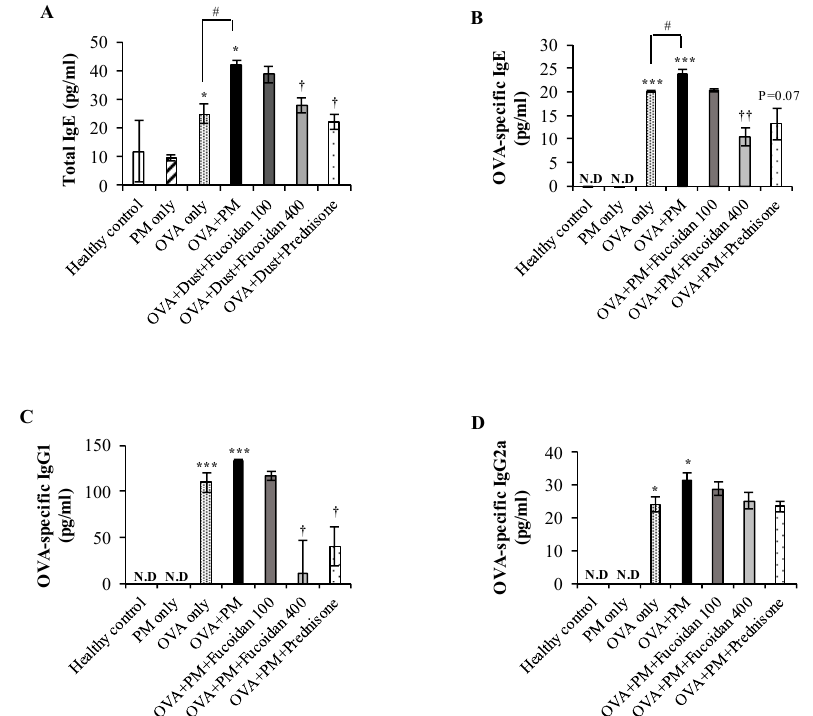
Figure 8. Effect of fucoidans on immunoglobulin levels in the serum. Levels of ( A ) total IgE, ( B ) OVA-specific IgE, ( C ) OVA-specific IgG1, and ( D ) OVA-specific IgG2a in serum. Values are expressed as means ± SEM ( n = 3). * ( p < 0.05), *** ( p < 0.0005) represent significant increases compared with the healthy control, and † ( p < 0.05), †† ( p < 0.005) represent significant decreases compared with the OVA + PM group. # ( p < 0.05) represents a significant increase compared with the OVA only group. N.D; not detected.